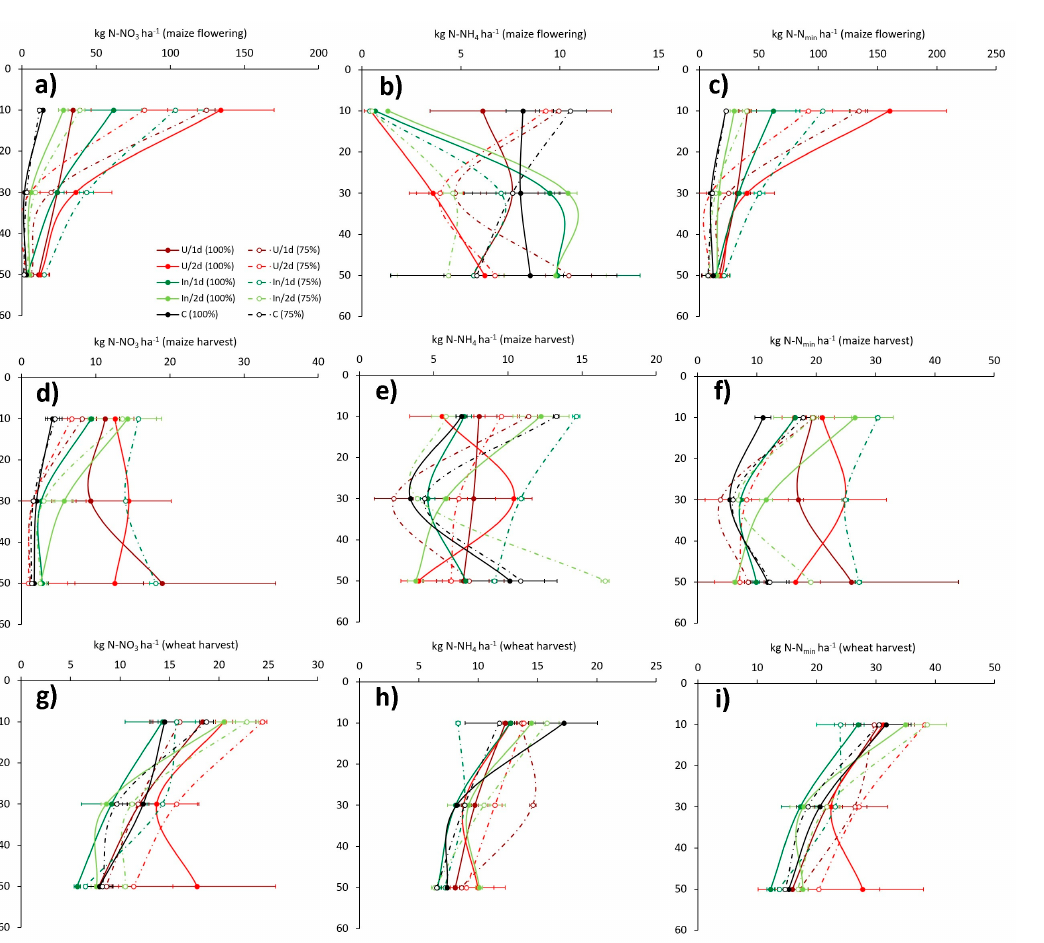
Figure 6. Soil mineral N content (( a , d , g ) NO 3 , ( b , e , h ) NH 4 , and ( c , f , i ) N min = NO 3 + NH 4 ) along the soil profile at different crop stages (( a – c ) flowering, ( d – f ) maize harvest and ( g – i ) wheat harvest). Bars represent the standard error. Treatments were a combination of urease inhibitor use (In), simple urea use (U), or no fertilizer (C), with fertilizer application in one (1 d) or two (2 d) dressings and optimally irrigated (100%) or sub-optimally irrigated (75%). After maize harvest, the soil was depleted of N min . Both U treatments presented 62 kg N ha − 1 at the upper 60 cm, between 34 and 44 kg N ha − 1 in the IN treatments, and 28 kg N ha − 1 in the control. The amount of NH 4+ was similar in all treatments and depths (around 7 kg N ha − 1 per treatment and depth), but NO 3- changed depending on the treatment and at different depths. On the surface, all the fertilized treatments presented a similar amount of NO 3- (12 kg N ha − 1 on average), larger than the control treatment (4 kg N ha − 1 ). Moreo- ver, the fertilized treatments applied in two dressings tended to increase the residual NO 3- with respect to that applied in one dressing at the surface (on average, 13.5 vs 10.3 kg N ha − 1 , respectively). At a depth of 30 cm, differences increased between the treatments. In general, treatments fertilized with regular urea presented larger residual NO 3- than the IN treatments (with an average difference of 7.7 N ha − 1 ), and treatments that applied the fertilizer in two dressings presented larger values than those seen in the one dressing ap- plication (with an average difference of 4.1 N ha − 1 ). Differences with respect to the control treatments were reduced for the IN treatments, but not for the U treatments. Finally, in the deeper layer, this tendency persisted and the IN treatments and the control presented similar results (2.3 kg N ha − 1 on average), much lower than the U treatments (15.7 kg N ha − 1 on average). Without plants in the field, this NO 3- in the lower part of the soil profile was prone to be leached via successive rainfall events, but it could also be indicative of previous leaching during the maize cropping season. It was also remarkable how inhibi- tors reduced the proportion of N min as NO 3- with respect to the NH 4+ (approaching the